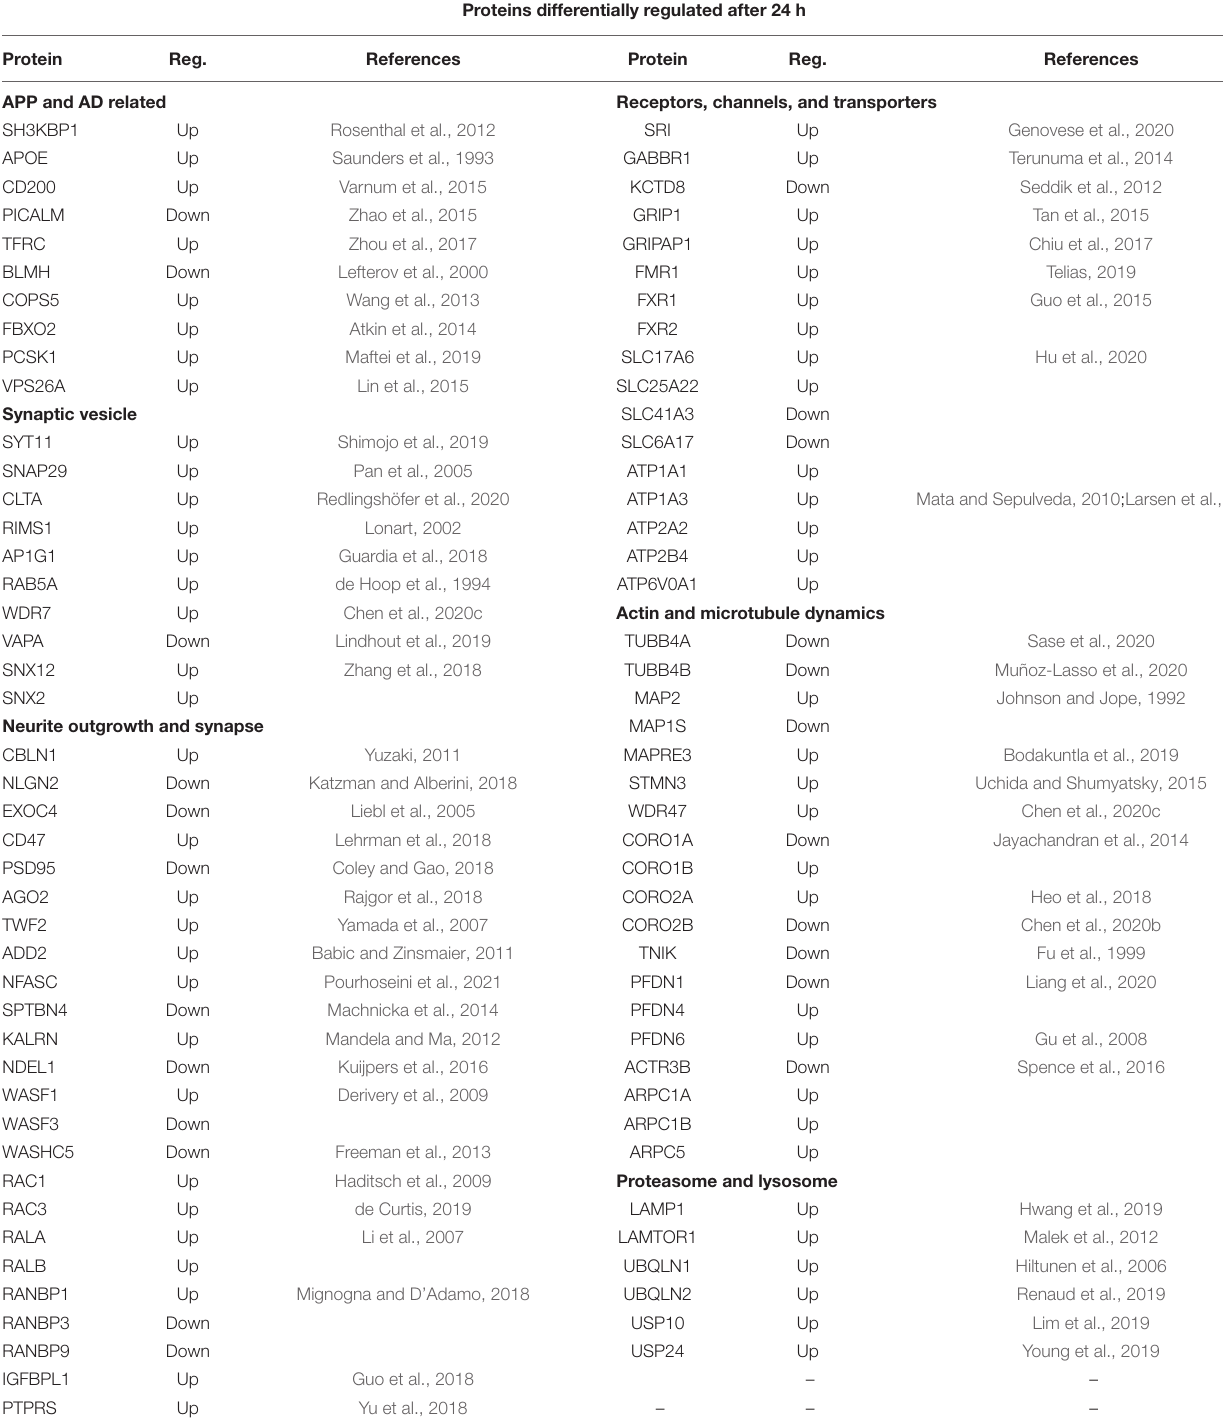
Proteins differentially regulated after 24 h